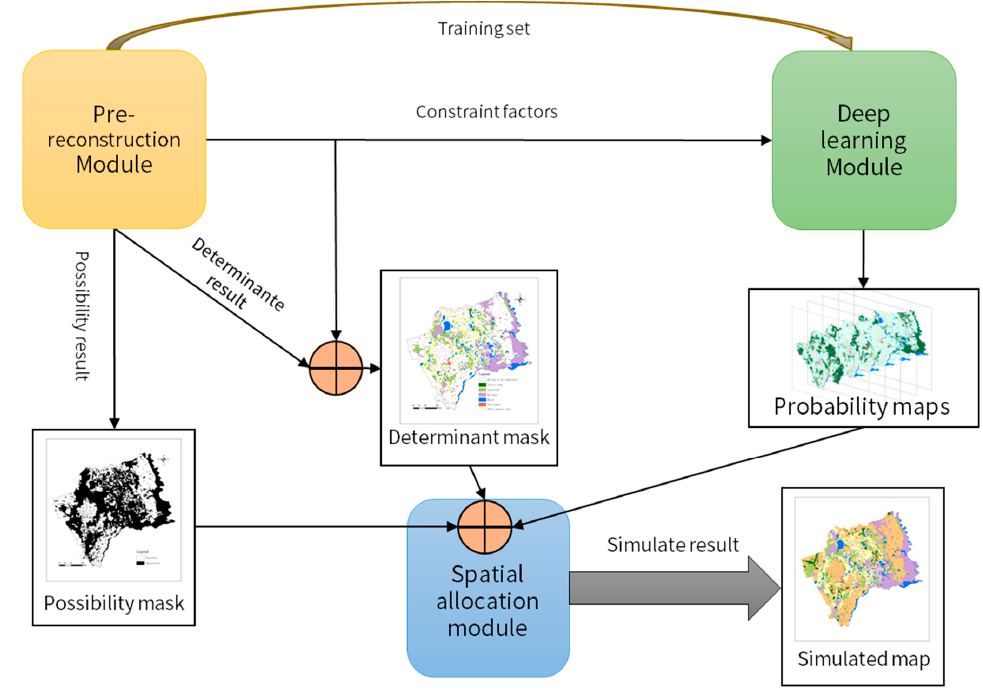
Figure 3. DLURM modeling framework.